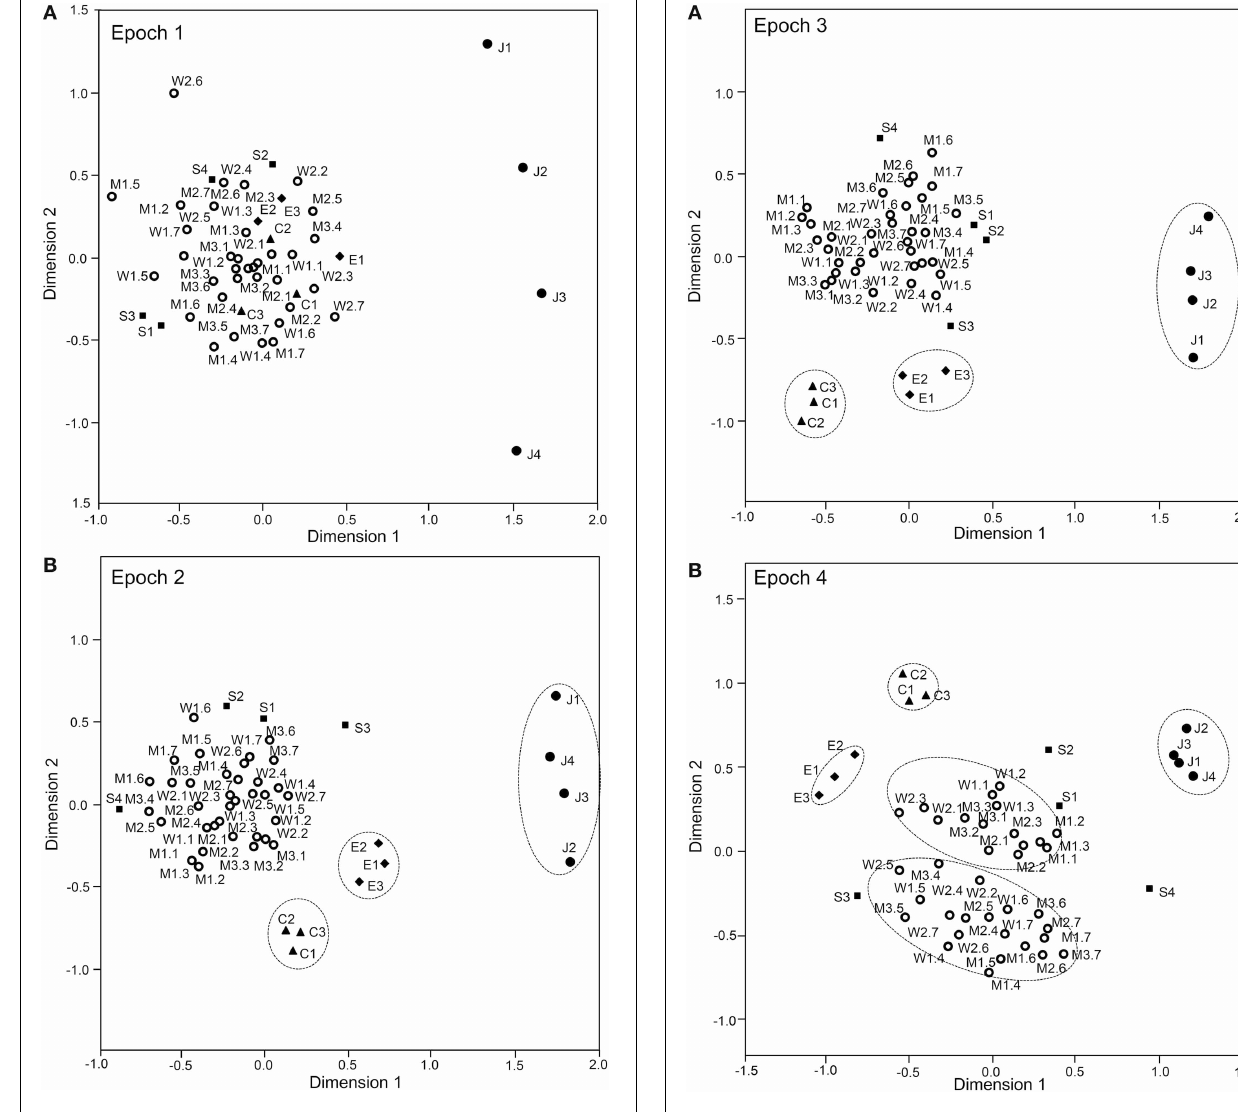
FIGURE 10 | Distributions of the 49 visual stimuli in the two-dimensional space resulting from multidimensional scaling in epoch 3 (A) and epoch 4 (B). In epoch 3 (A) , four groups were recognized: one large group that consisted of various stimuli, including the facial photos and simple geometric patterns, and three small groups corresponding to the face-like patterns, cartoon faces, and eye-like patterns. In epoch 4 (B) , five groups were recognized: two large groups of neurons responding to stimuli corresponding to the frontal faces and profiles and three small groups of neurons responding to stimuli corresponding to the face-like patterns, cartoon faces, and eye-like patterns. Other descriptions are the same as those for Figure 11